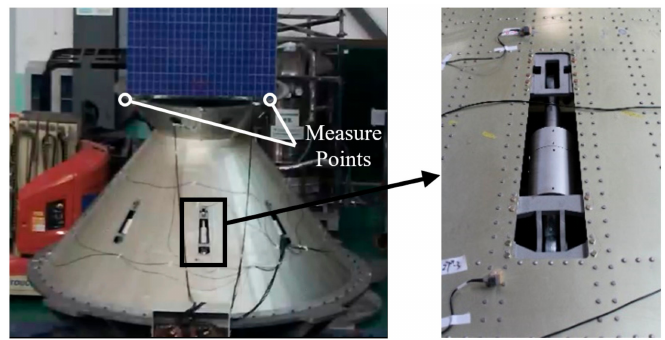
Figure 14. Damping state PAF and the damper.